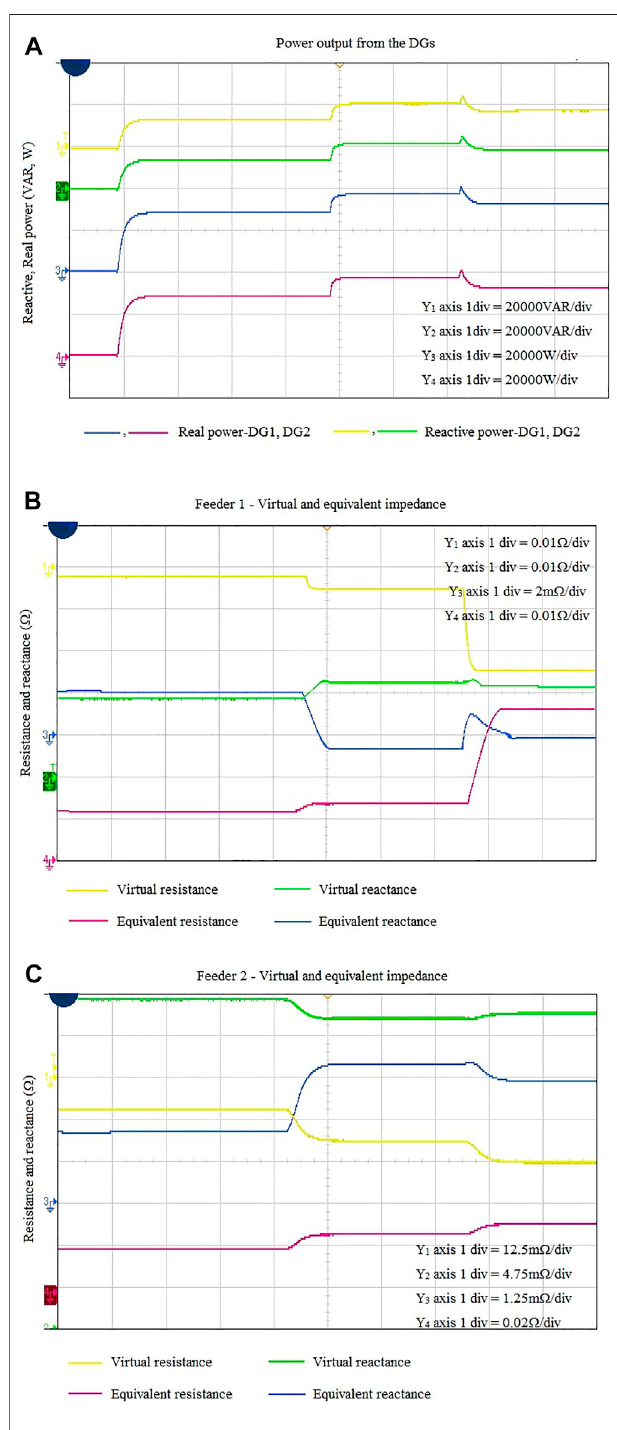
FIGURE6| OPAL-RTresultsforEQUALDGRATING: (A) powersharing by DGs; (B) equivalent impedance and virtual impedance of line 1; and (C) equivalent impedance and virtual impedance of line